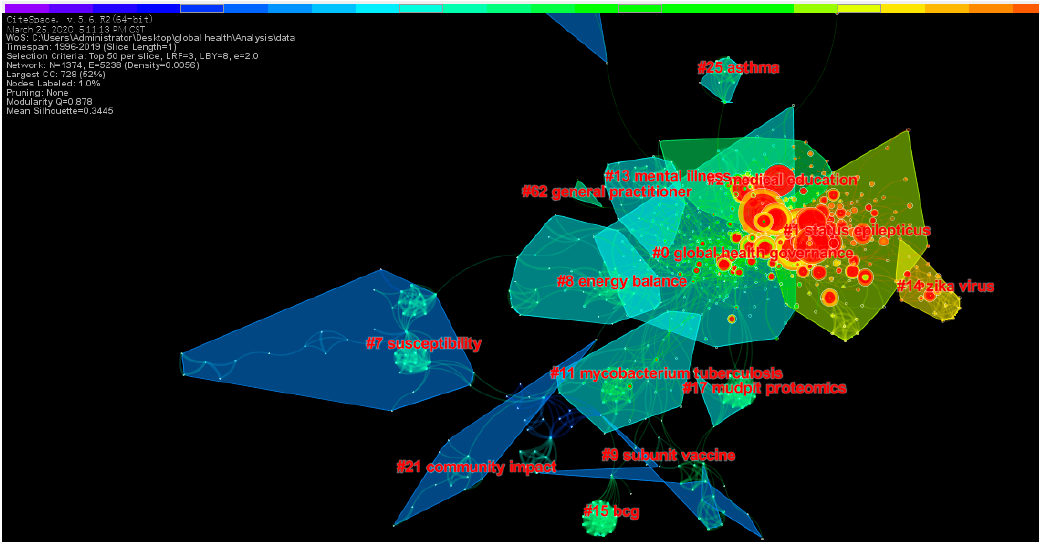
Figure 8. Knowledge map of literature cluster. In CiteSpace, clusters are named by citing the of the literature, and the log-likelihood algorithm (LLR) used. keywords of the literature, and the log-likelihood algorithm (LLR) used.